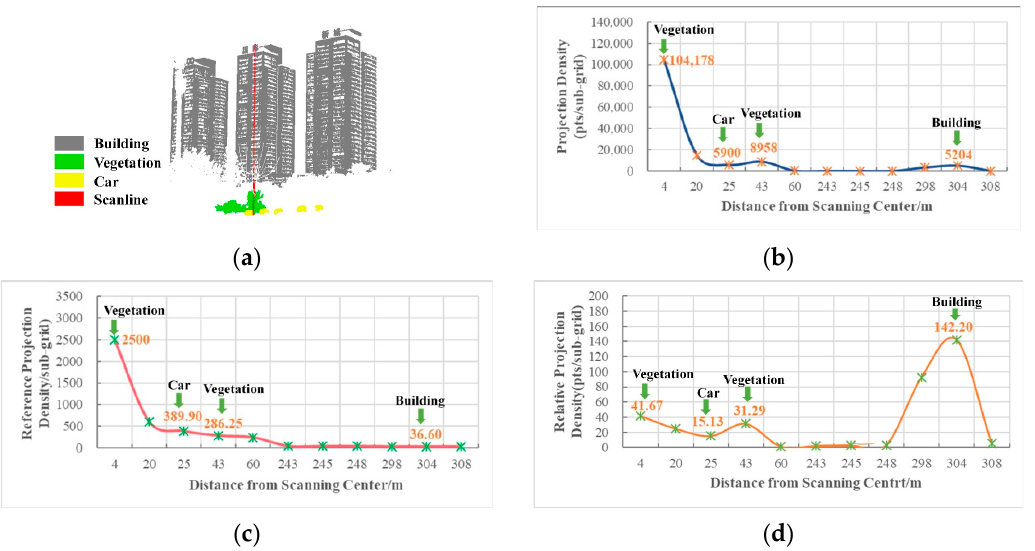
Figure 7. Comparison of three density definitions. ( a ) Scanline and surrounding objects, ( b ) Tradi- tional projection density, ( c ) Reference projection density, ( d ) Relative projection density.